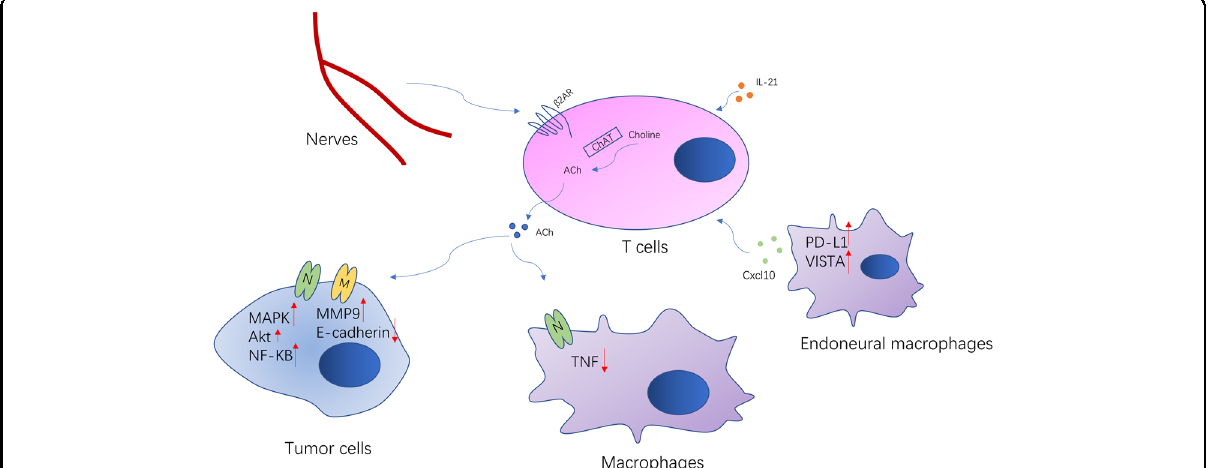
Fig. 4 Crosstalk between nerves and immune cells. ACh is synthesized in the T cells by enzyme choline acetyltransferase. Adrenergic innervation stimulates production of the T-cell-derived ACh, which is involved in regulating the tumor immunity and tumor biology behavior. Endoneural macrophages also regulate tumor metastasis through CXCL10. CXCL10 recruits the myeloid cells and suppresses T cells via VISTA and